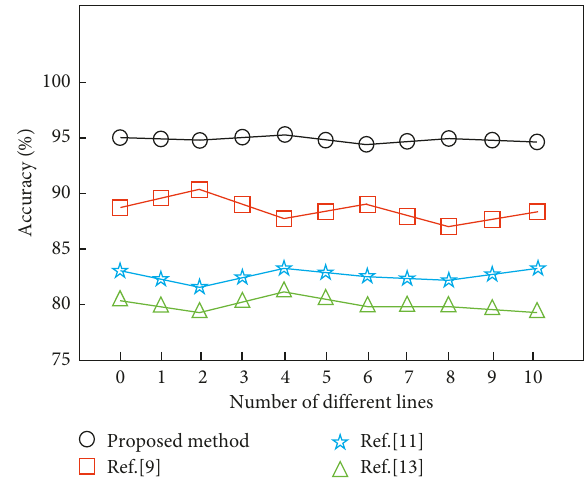
Figure 4: Diagnostic accuracy of different algorithms for pole-to- ground faults.